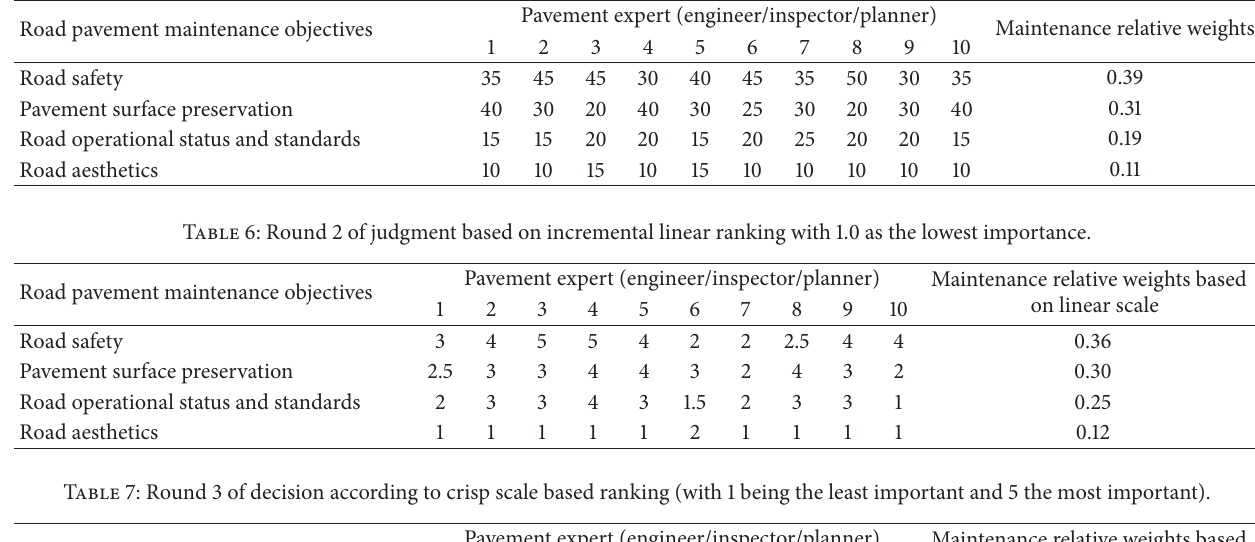
Table 5: Round 1 of decision based on importance of allocation or weighting.